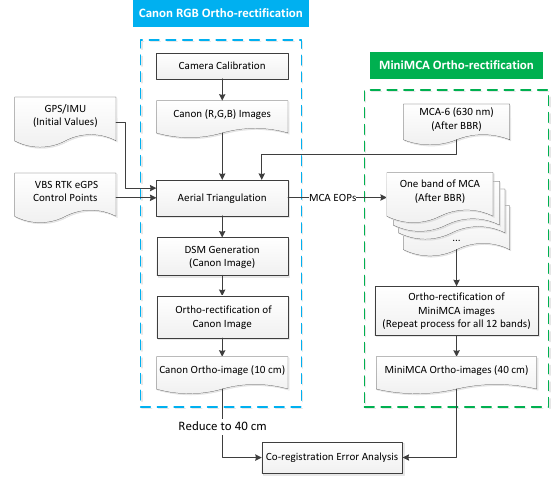
Figure 5. Canon RGB and MiniMCA ortho-images rectification